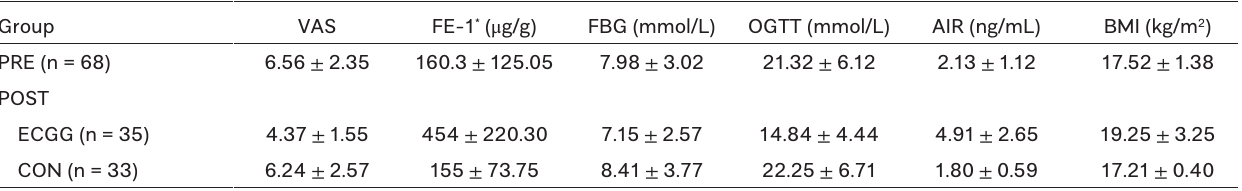
Table 3. Effect of ECGG Improvement in Clinical Symptoms in Patients with PDS Group